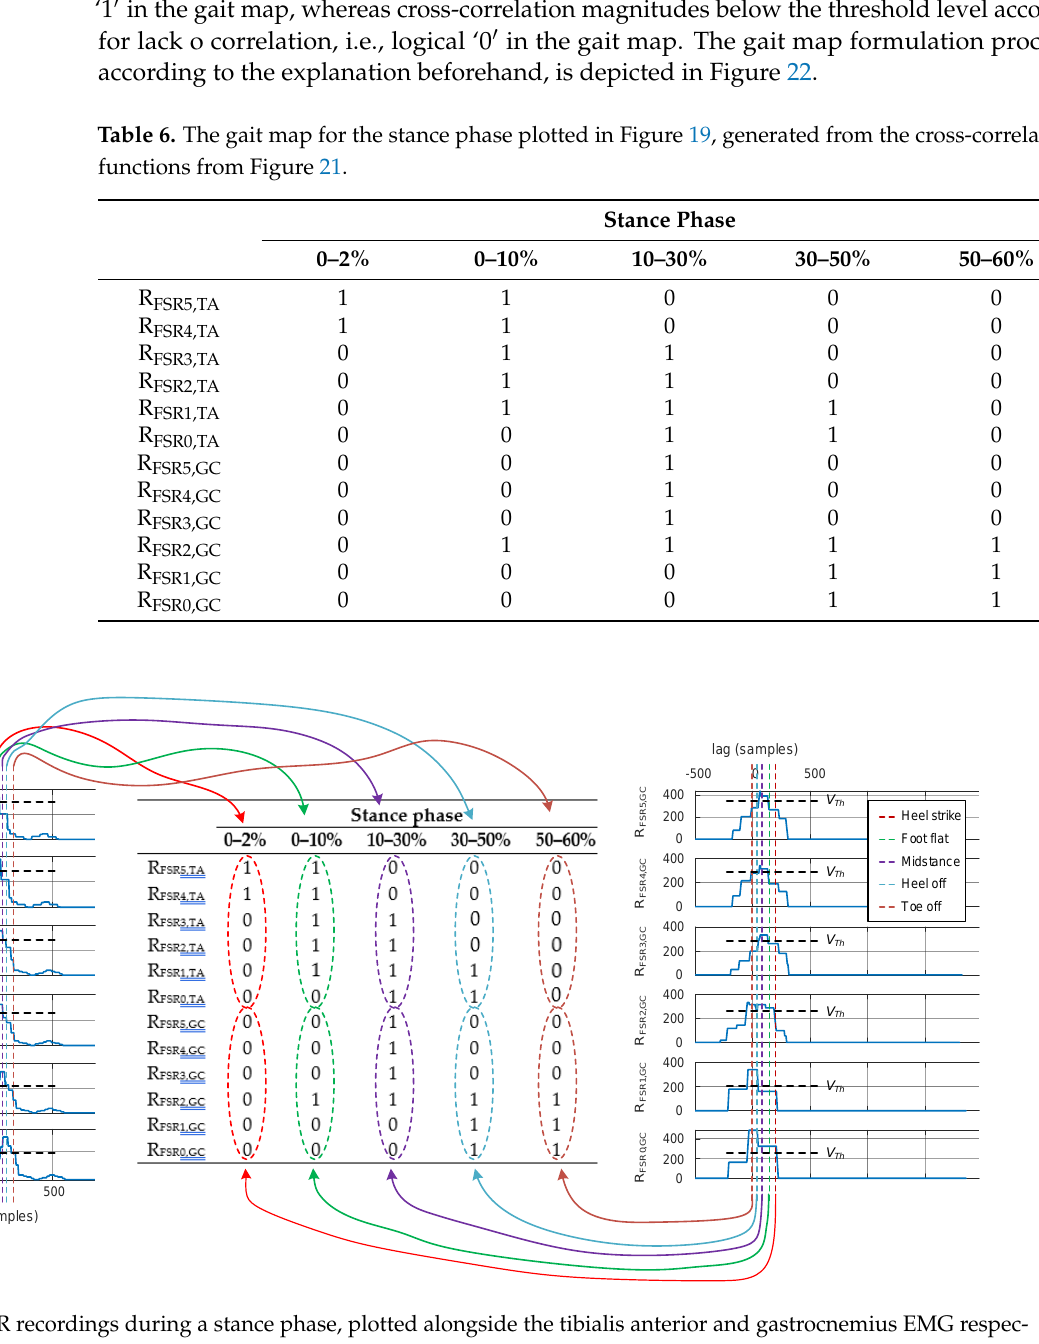
Figure 22. The FSR recordings during a stance phase, plotted alongside the tibialis anterior and gastrocnemius EMG respectively.